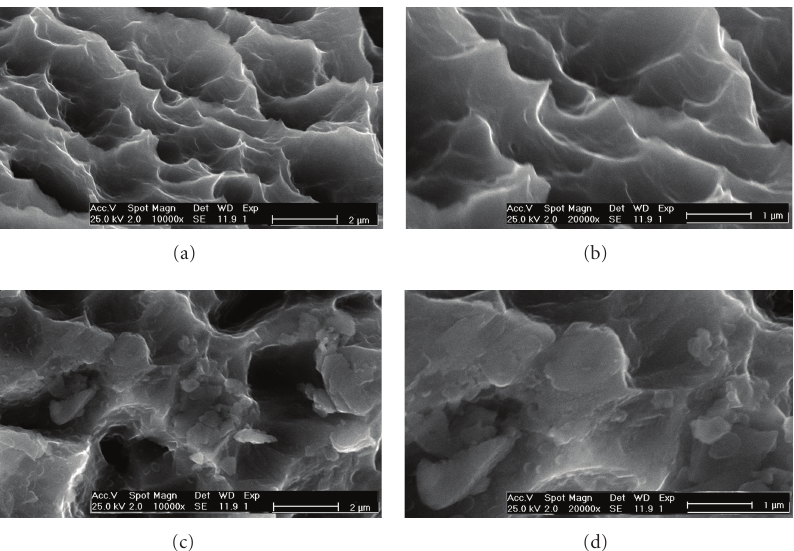
Figure 1: SEM images of the samples before coating with fibronectin. (a) and (b) Porous samples (acid treatment). (c) and (d) PorousNano samples (acid treatment followed by fluoride ion modification).